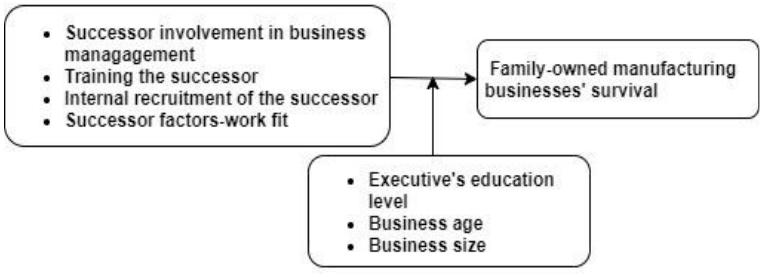
Figure 1. Conceptual framework; Source: Literature